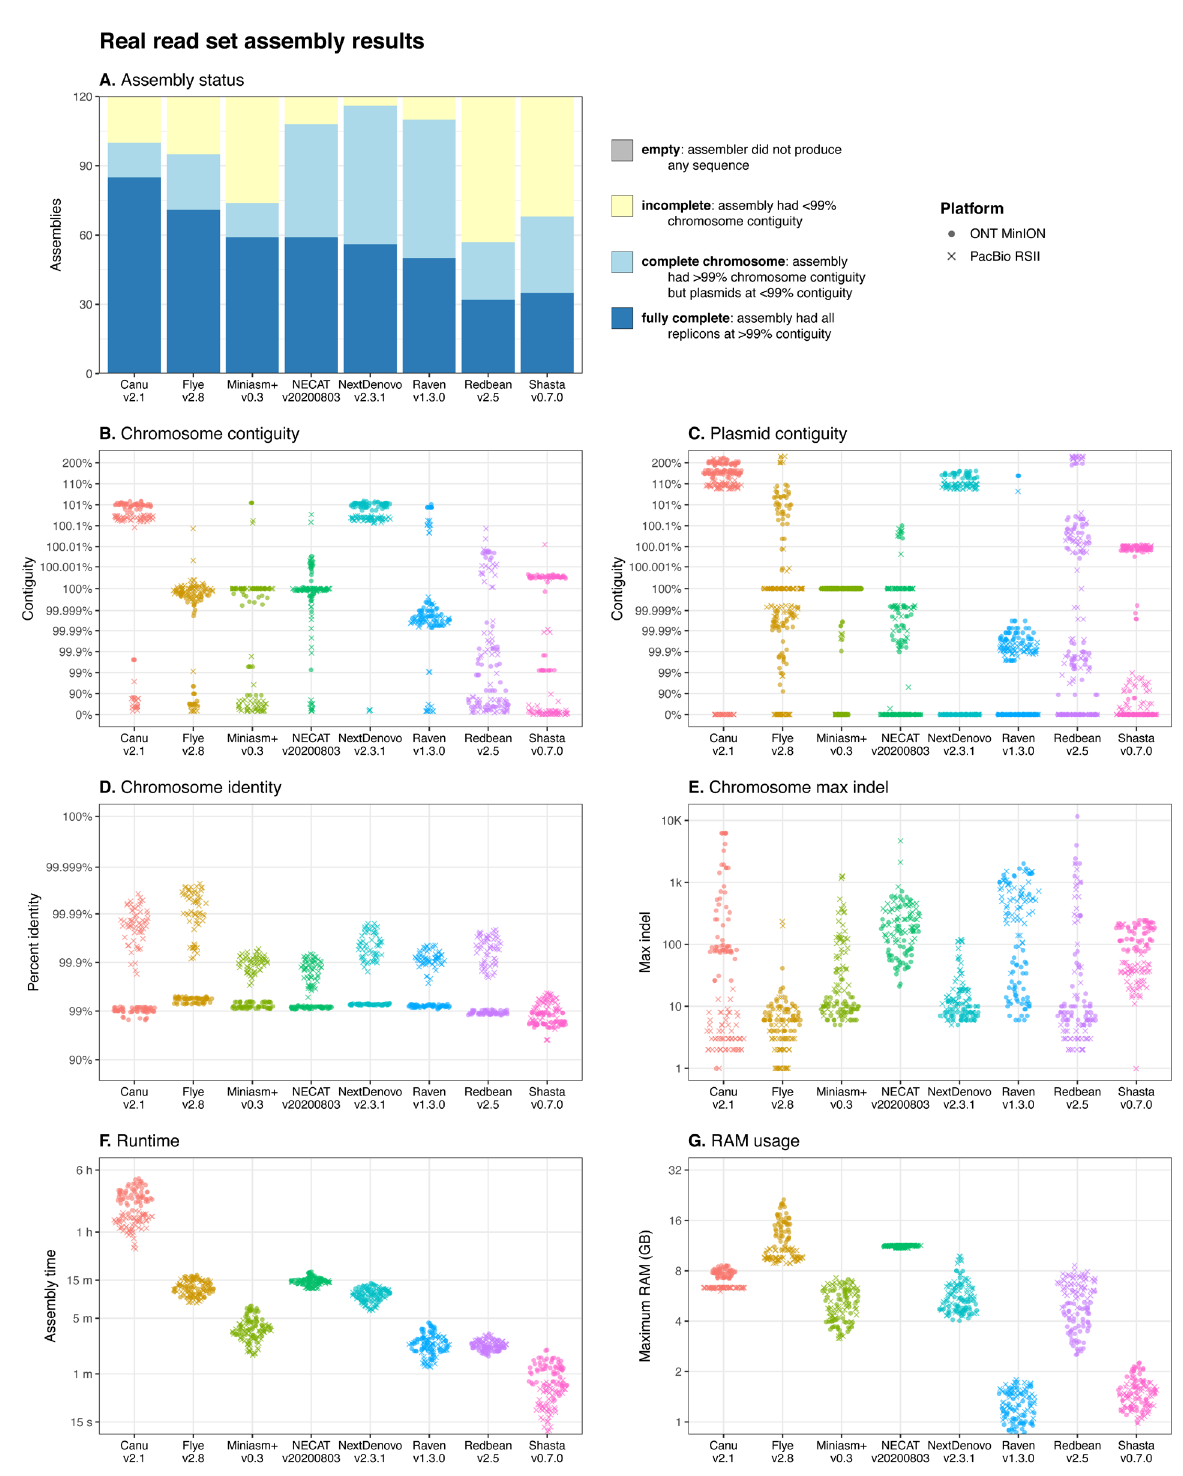
Figure 2. Assembly results for the real read sets, half containing ONT MinION reads (circles) and half PacBio RSII reads (X shapes). ‘Miniasm+’ here refers to the entire Miniasm/Minipolish assembly pipeline. ( A ) Proportion of each possible assembly outcome. ( B ) Relative contiguity of the chromosome for each assembly, showing cleanliness of circularisation. ( C ) Relative contiguity of all plasmids in the assemblies, showing cleanliness of circularisation. ( D ) Sequence identity of each assembly’s longest alignment to the chromosome. ( E ) The maximum indel error size in each assembly’s longest alignment to the chromosome. ( F ) Total time taken (wall time) for each assembly. ( G ) Maximum RAM usage for each assembly.